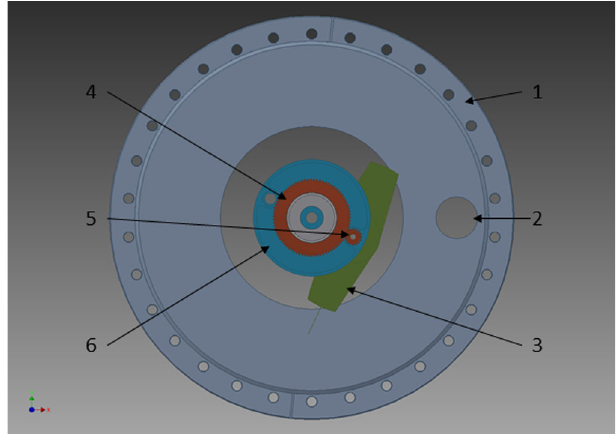
FIG. 3 (color online). A 3D rendering of the gears setup: (1) vacuum flange; (2) beam pipe; (3) blade with attached carbon wire; (4) stationary gear G 1 ; (5) rotating gear G 2 ; (6) rotating gear